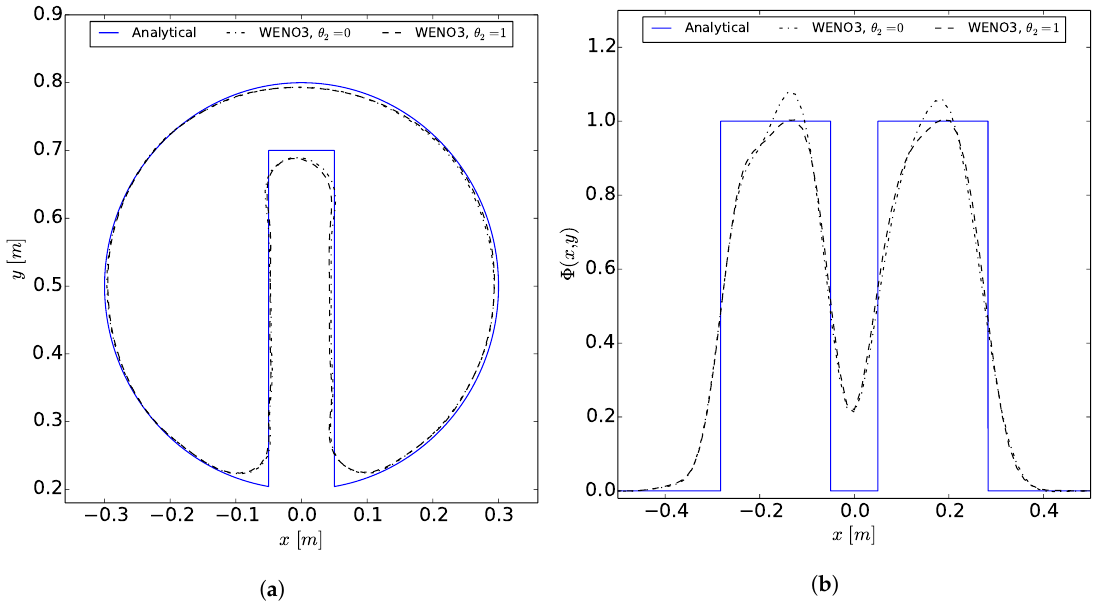
Figure 16. Results of the limited and unlimited third-order WENO scheme for Zalesak’s disk on 128 128 squares. ( a ) Contour plot of Φ = 0.5; ( b ) slice of the disk at y = 0.6 ×